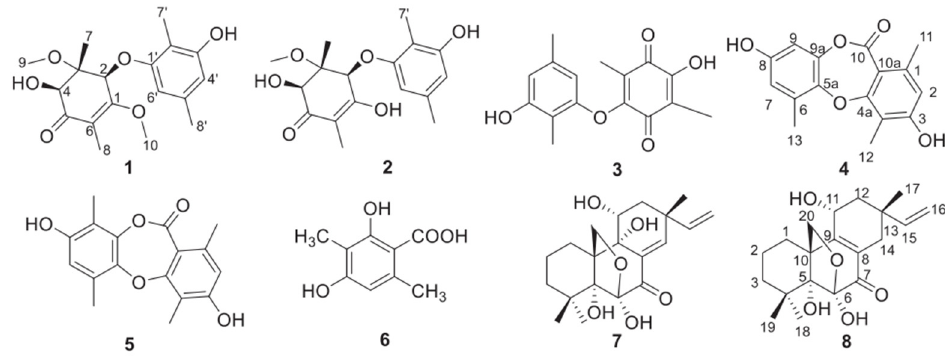
Figure 1. Chemical structures of 1–8; the chemical structure of DTB: C20H28O6, mass: 364.19.